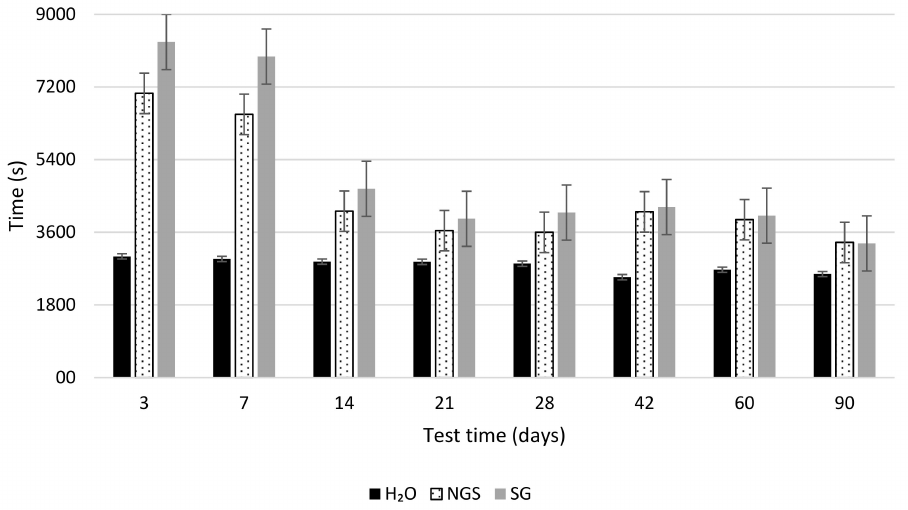
Figure 3. Result of Karsten tube water absorption test for NSG, SG, and H 2 0 treated concrete